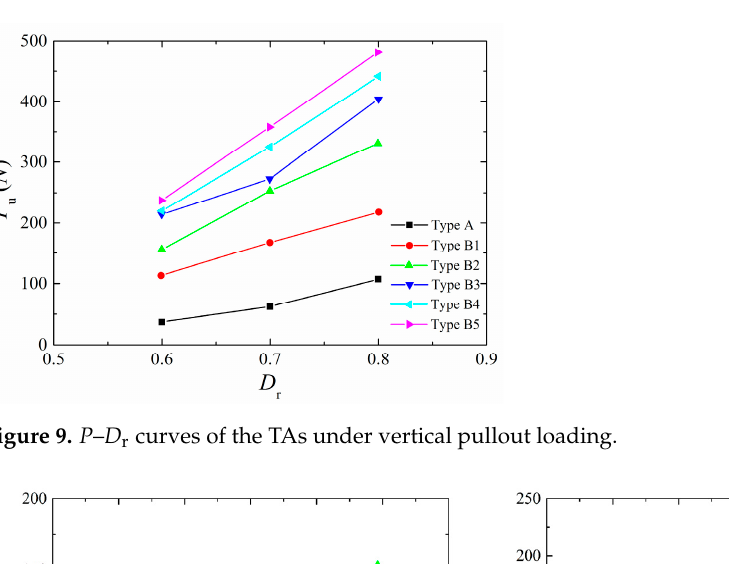
Figure 8. Effects of D r on the load–displacement curves of the TAs under vertical pullout loading ( a ) Types A and B1; ( b ) Types B2 and B3; ( c ) Types B4 and B5.